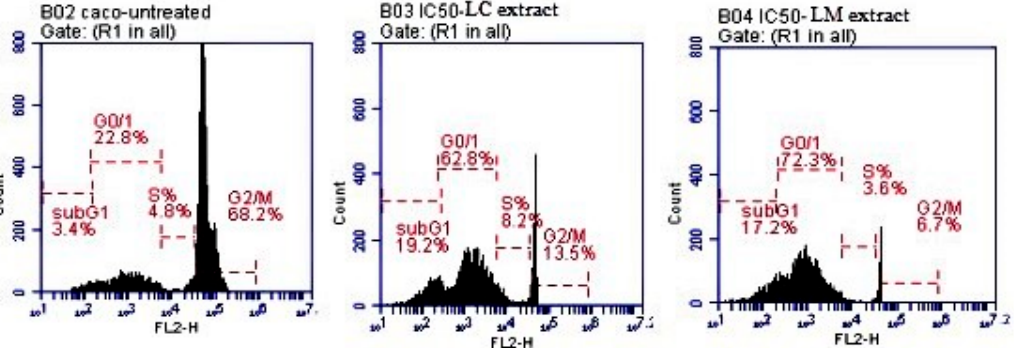
Figure 6. Cell cycle phases of Caco cells treated with L. camara and L. montevidensis extracts (at their IC 50 concentrations) after 48 h of treatment.